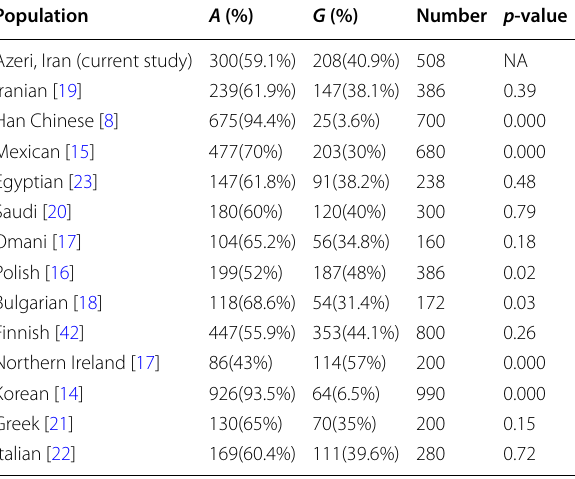
Table 3 Frequency 0f IL-10 alleles -1082 in healthy populations from various